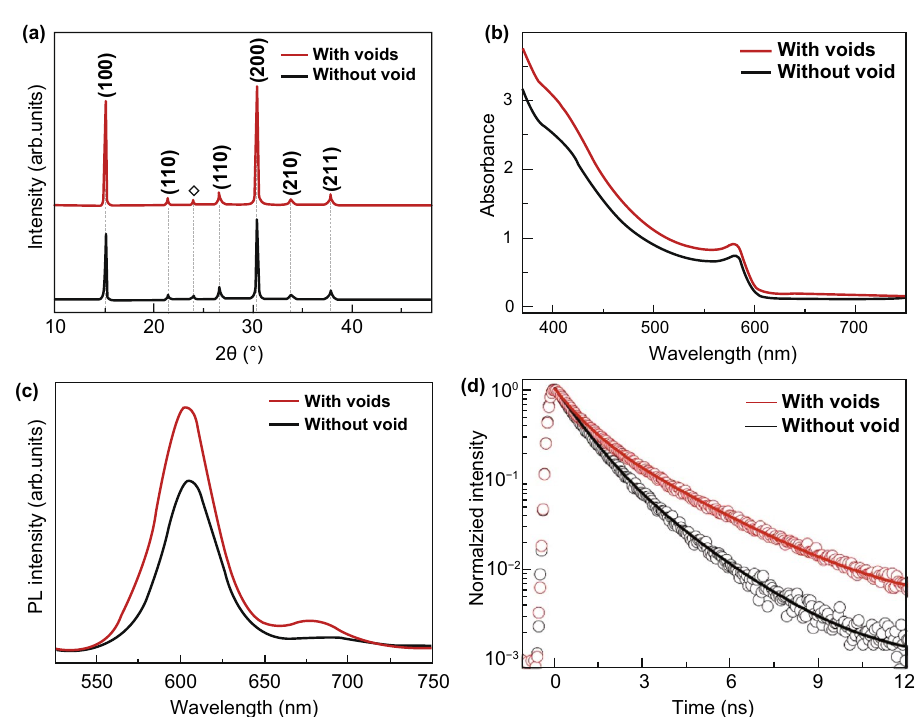
Fig. 3 a XRD patterns and b UV–vis absorption spectra of CsPbIBr 2 films without and with interfacial voids, c steady-state PL spectra and d TRPL curves of CsPbIBr 2 films without and with interfacial voids on insulating glass substrates instead of FTO/TiO 2